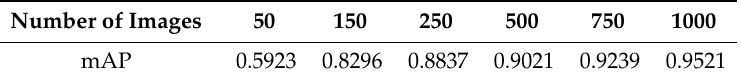
Figure 14. P–R curves of four electronic components for the model trained with different numbers of images: ( a ) capacitor of 470 µ F; ( b ) capacitor of 220 µ F; ( c ) capacitor of 22 µ F; ( d ) inductor. Table 7. mAP results of different dataset size.